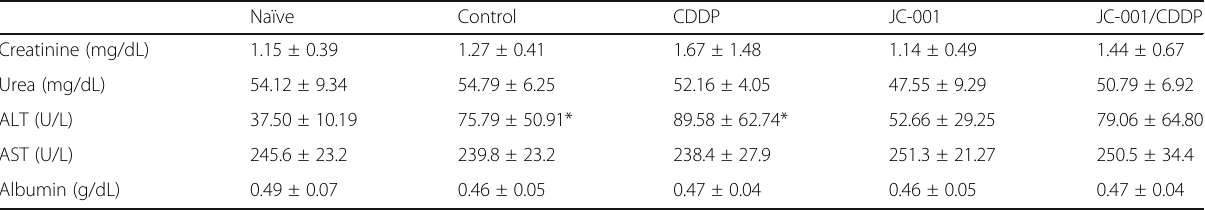
Table 1 Effect of JC-001/CDDP and combined treatment on serum creatinine, urea, ALT, AST and albumin Naïve Control CDDP